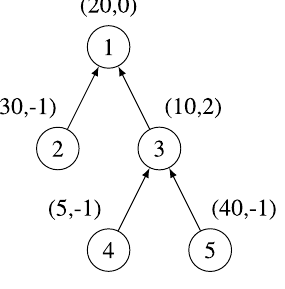
Fig. 1 Graph for Example 3.1. Nodes are indexed from 1 to 5, and every node is labeled with a pair ( score , sentiment